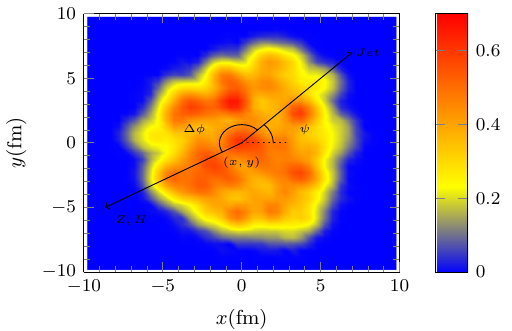
Fig. 7 Graphical depiction of a Z or H trigger jet process going in an almost back-to-back configuration by an angle (cid:2)φ in the transverse plane.Thepositionandorientationofthishardscatteringinthemedium is governed by its coordinate of origin ( x , y ) and azimuthal angle ψ of the jet. The colorbar represents the local temperature in